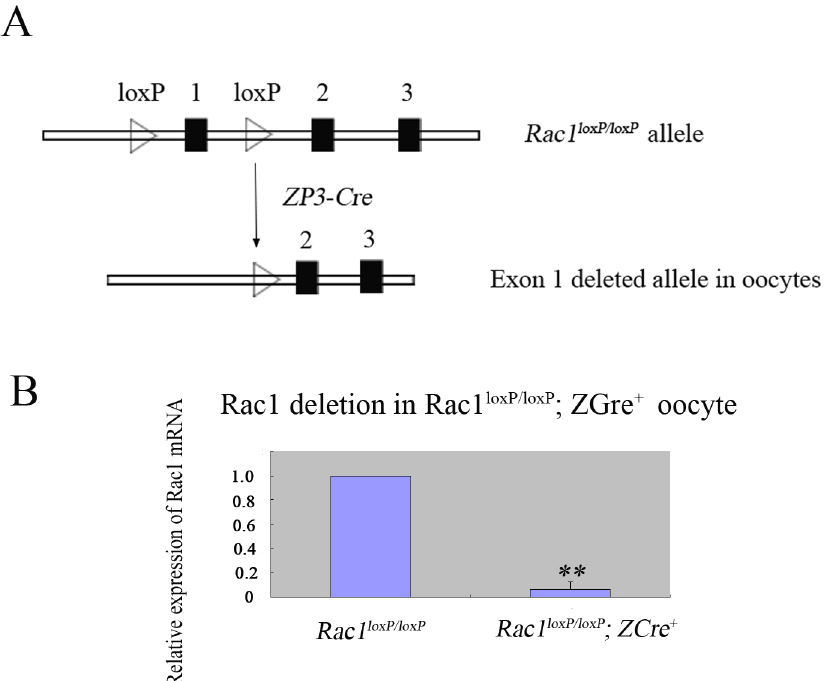
Fig 1. Specific deletion of Rac1 in mouse oocyte. (A) Schematic representation for deletionof Rac1 exon 1 by ZP3-Cre -mediatedrecombinase in oocytes. (B) Quantificationalreal-time PCR analysisshowing the Rac1 deletionin oocytes of Rac1 loxP/loxP ; ZCre + mice. The GV oocytes from Rac1 loxP/loxP ; ZCre + and Rac1 loxP/loxP mice were used for RNA isolationand quantitative RT-PCR. The experimentswere repeated three times. ** P < 0.01.